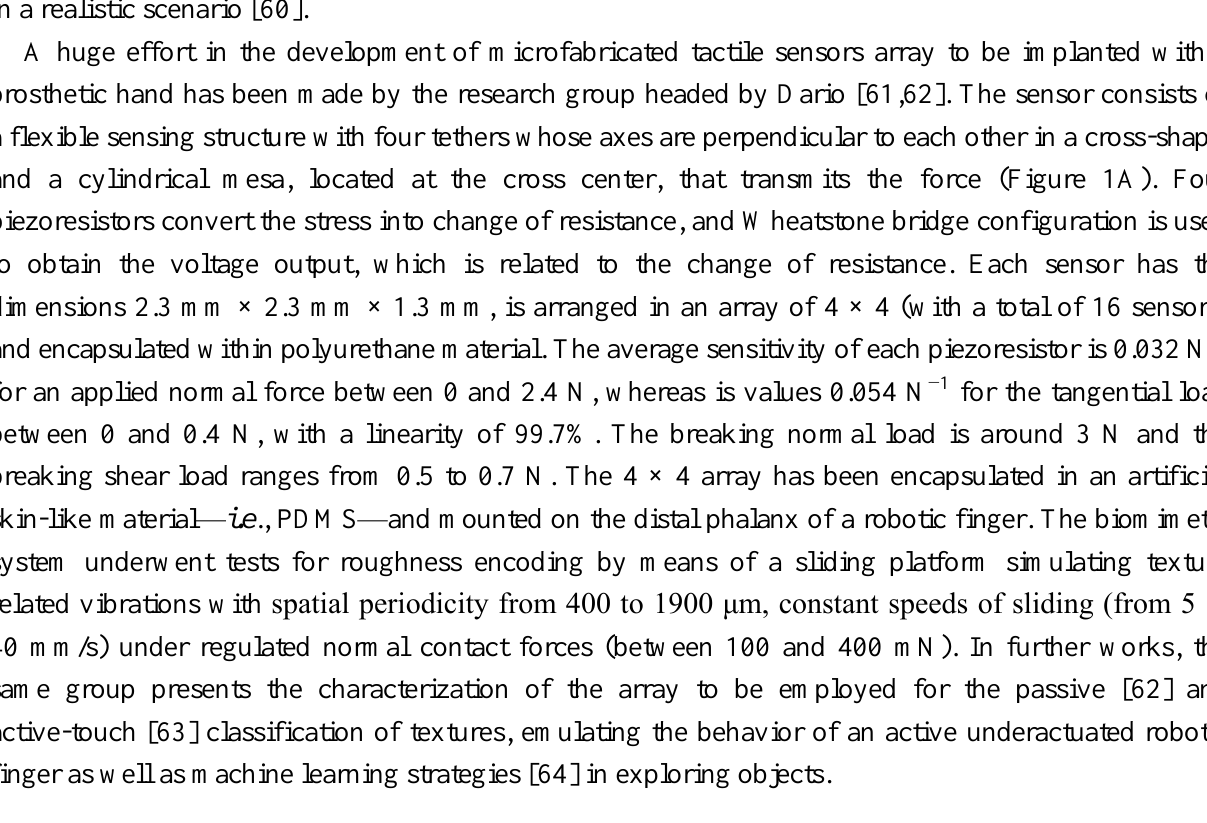
Figure 1. ( A ) Piezoresistive array sensor for robotic finger [63] and ( B ) finger-shaped piezoelectric tactile sensor